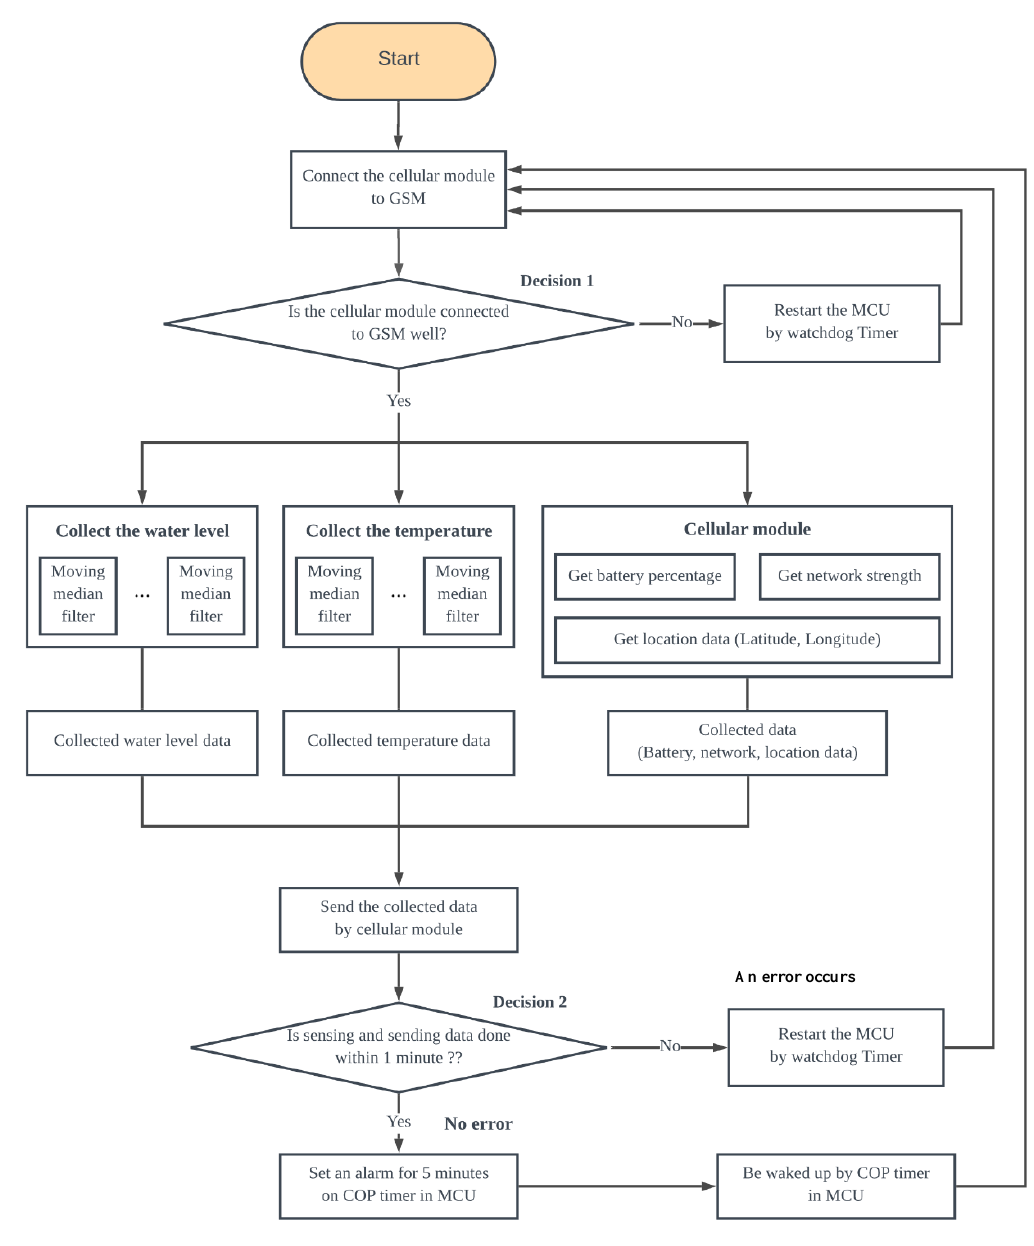
Figure 2. Flowchart of basic low-cost UWLD system with a single MCU and an ultrasonic